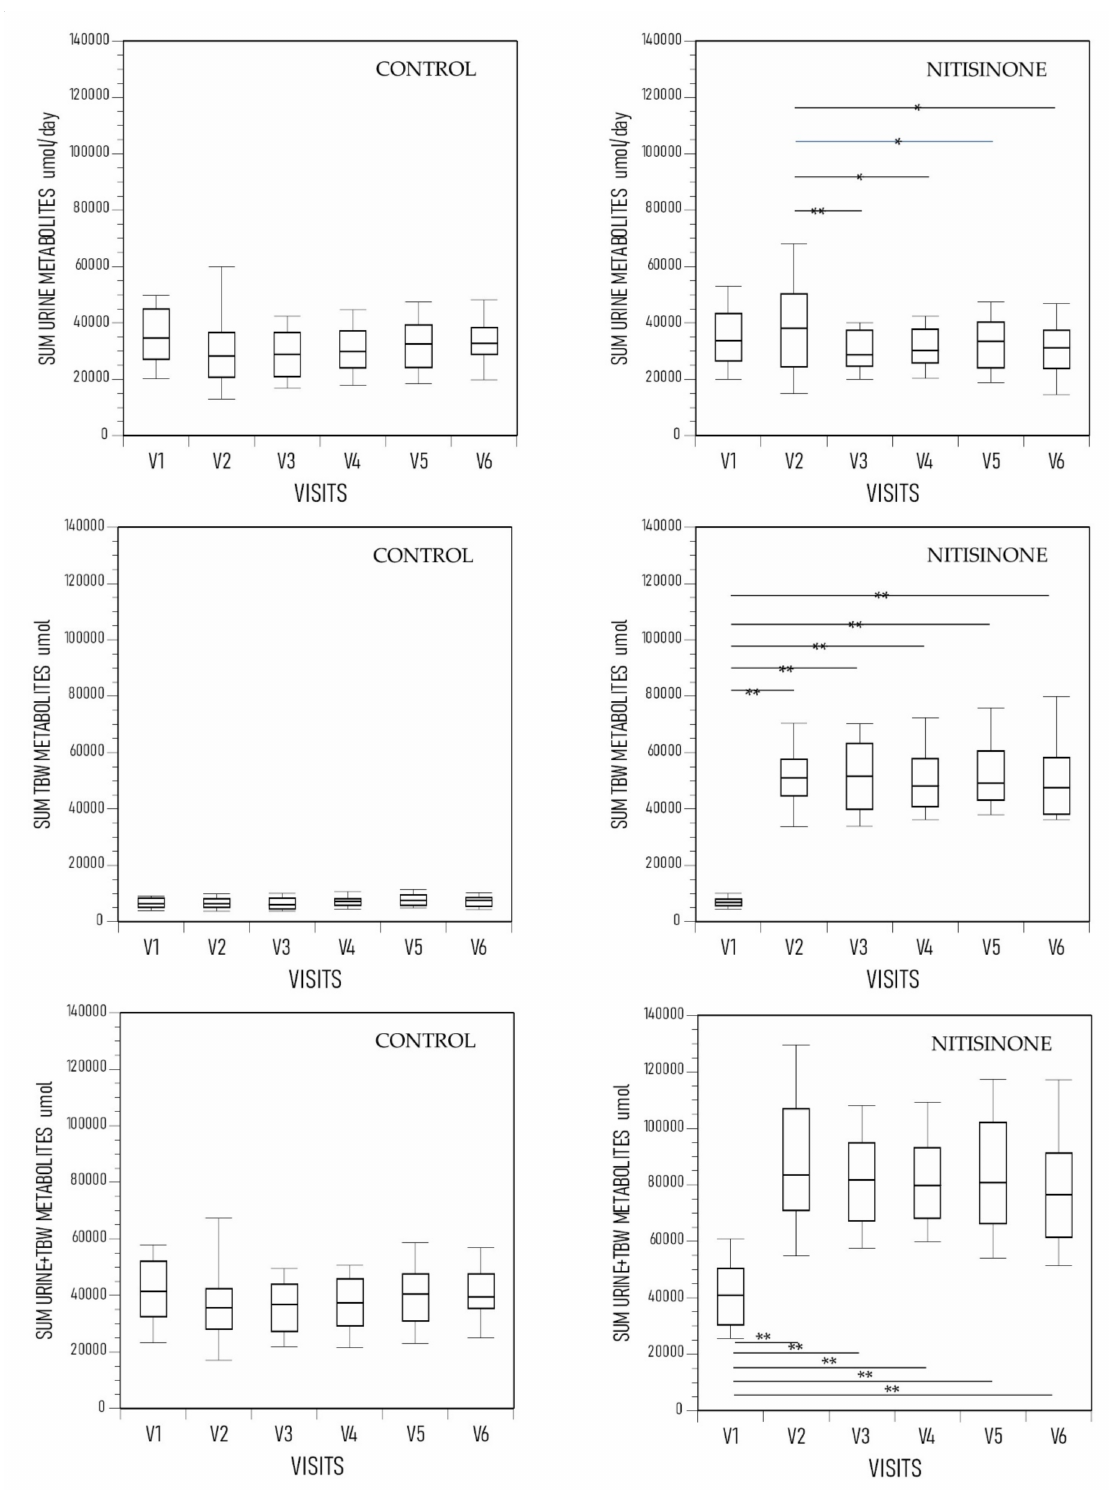
Figure 1. The SUM URINE METAB, SUM TBW METAB and SUM METAB in the control and the nitisinone group of the SONIA 2. ( p values only indicated for between-visit comparisons where statistical significance was achieved.) The visits range from V1 (baseline), V2 (month 3), V3 (month 12), V4 (month 24), V5 (month 36) to V6 (month 48) (data shown as boxplots with median) (statistical significance p expressed * <0.05, ** <0.01, and *** <0.001